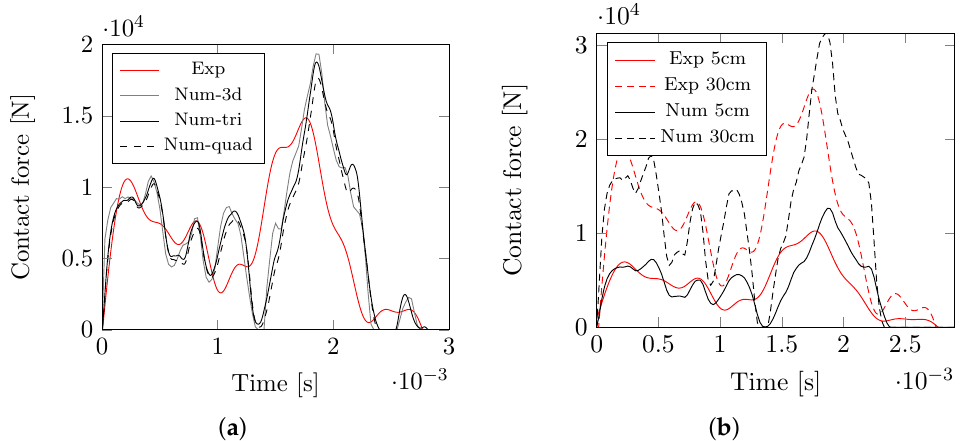
Figure 8. Comparison of evolution of measured and predicted contact force for nondestructive test: ( a ) influence of finite element type—impact height of 10 cm; ( b ) application of triangular mesh for impact heights of 5 cm and 30